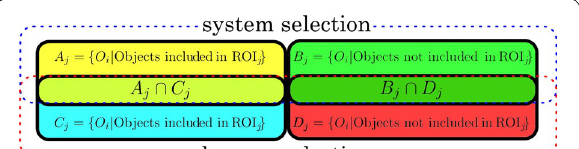
Fig. 7 Set of objects grouped by selection